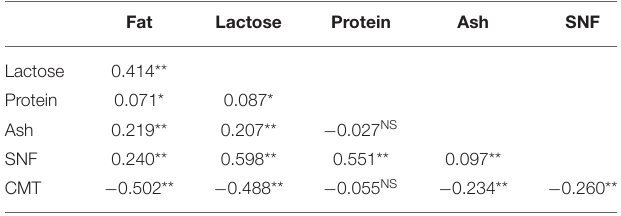
TABLE 4 | Correlations between milk SCC and milk components in lactating dairy